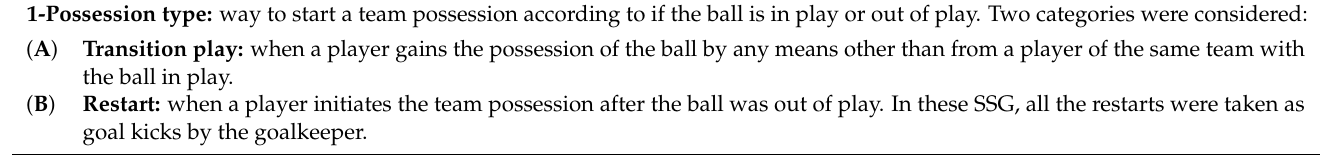
Table 2. Description and categories for the dimensions related to the start and development of the team